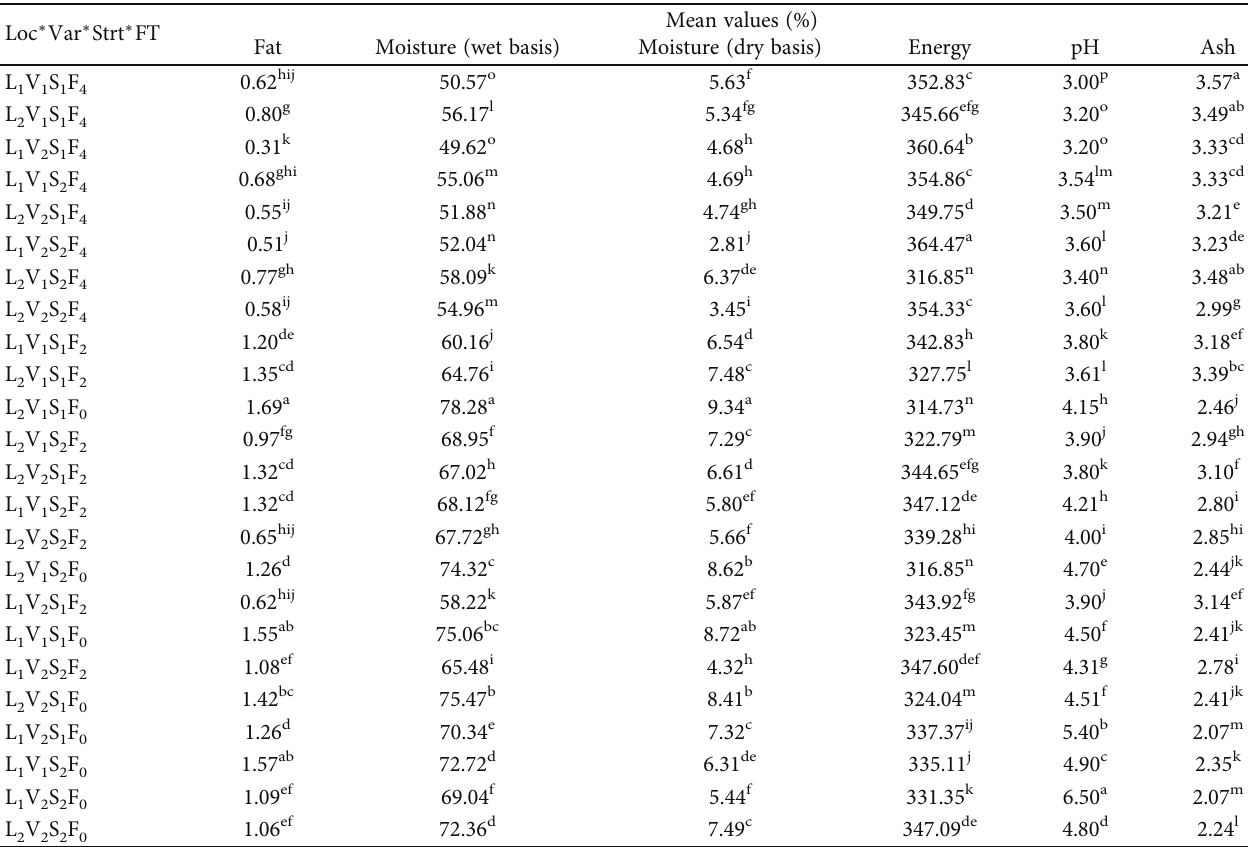
Table 4: Proximate composition and physical characteristics of traditionally fermented kocho Ethiopian false banana foodstu ff (four- factorial